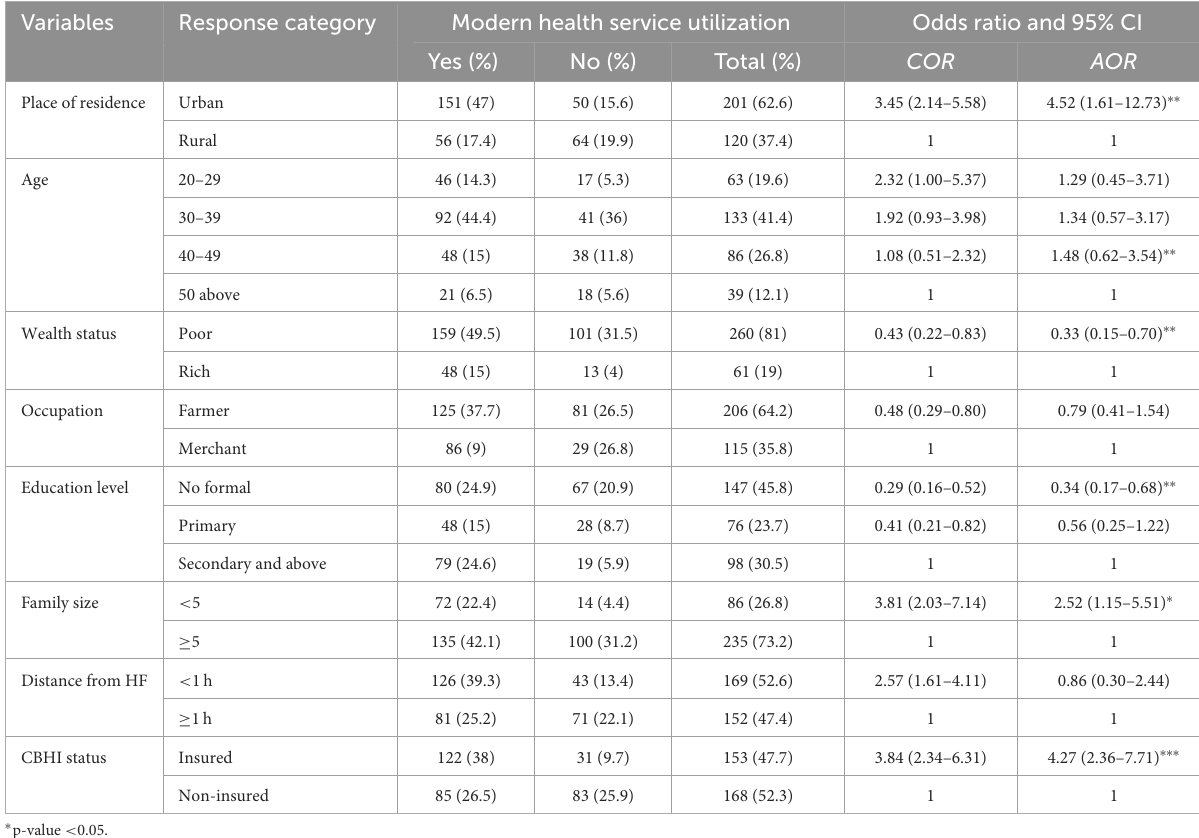
TABLE 3 Predictors of modern health service utilization among households ( n = 321) in the Gida Ayana district, Oromia Regional State, Ethiopia, 2022.